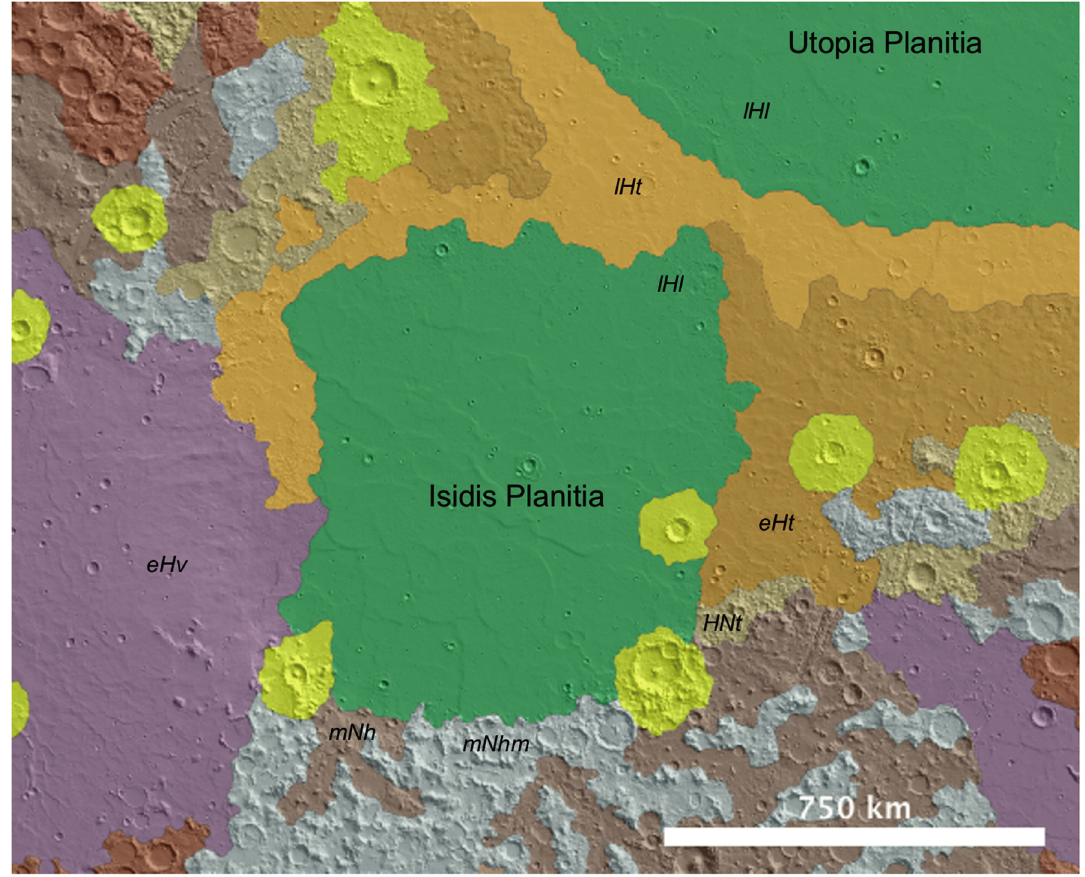
Figure 2. Geological map of Isidis Planitia and surrounding areas, constructed from shapefiles from [5] overlain on a MOLA shaded relief map, using Java Mission-planning and Analysis for Remote Sensing (JMARS). Unit symbols are explained in the text. Yellow units are Amazonian and Hesperian impact units ( AHi